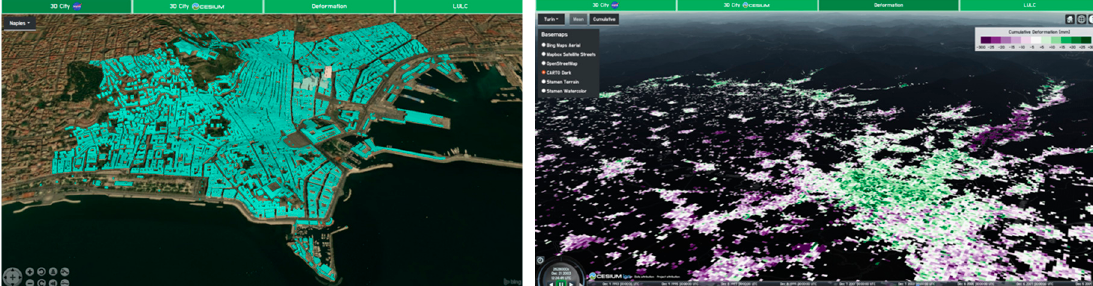
Figure 5. The Urban GEO BIG DATA client: OpenStreetMap data visualization with NASA World Wind (left) and ground displacements with Cesium JS (right). These open source virtual globes are not in the OSGeo software stack but Cesium JS is distributed on OSGeo Live (Table 3) [42,43].